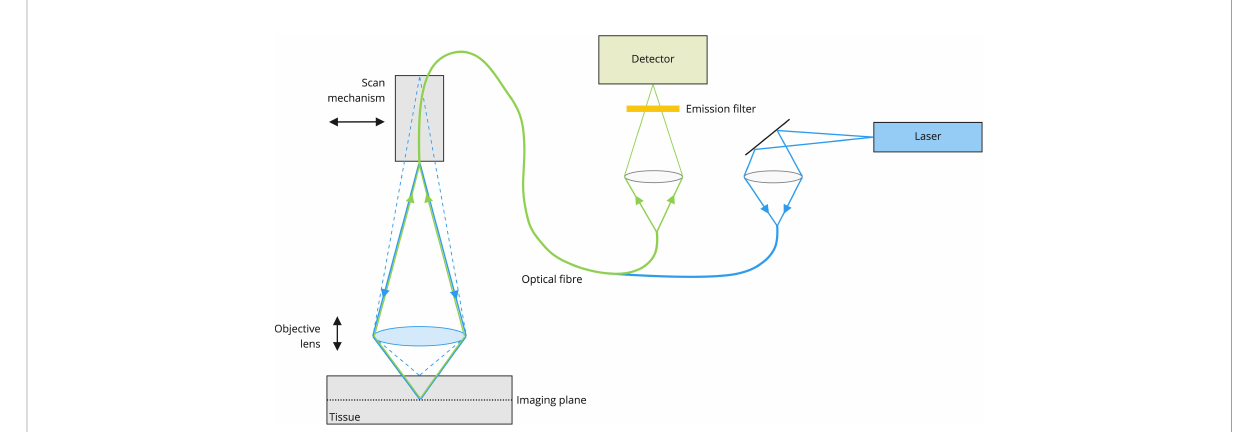
FIGURE 1 CONVIVO system mechanism of action. A laser-beam with a speci fi c wavelength is focused on a point inside the object at a speci fi c Z depth. A fl uorescent dye that is in the tissue of interest is excited by the laser light and the fl uorescence is collected by the lens system and focused onto the tip of the scanned delivery optical fi ber, that acts as a confocal pinhole rejecting light other than that from the set Z depth. Then, the fl uorescent light is carried to the confocal processor via the optical fi ber through a fi ber based optical coupler and into a detector, which synchronously samples the fl uorescence providing an electrical representation of the light intensity that is recorded as a digital sample. The digital samples are constructed into an image frame that is sent via a digital interface to the integration computer. The integration computer uses custom host software to deliver the image data to a monitor for display and further